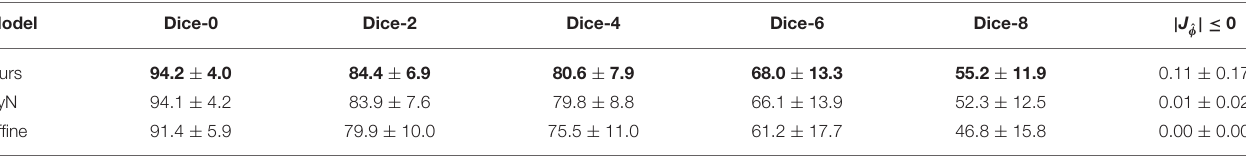
Bold values indicate the highest (= best) Dice score in the various